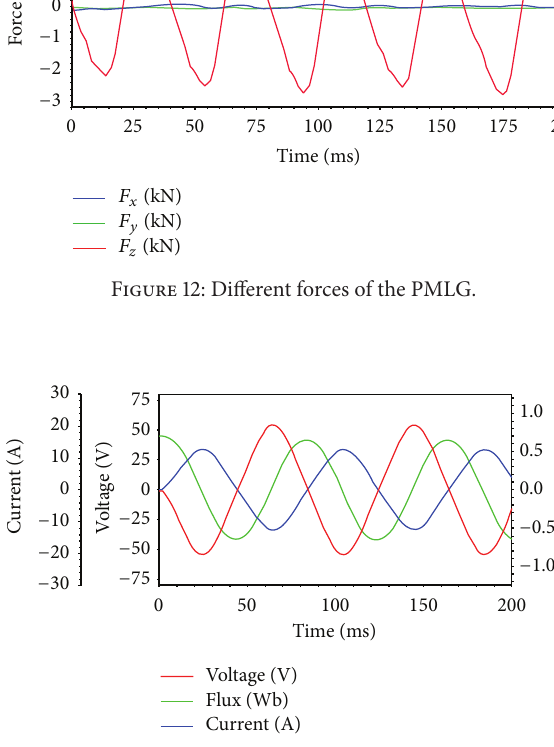
Figure 13: Induced voltage, current, and flux linkage.